Question: Does the plotted quantity increase or decrease?
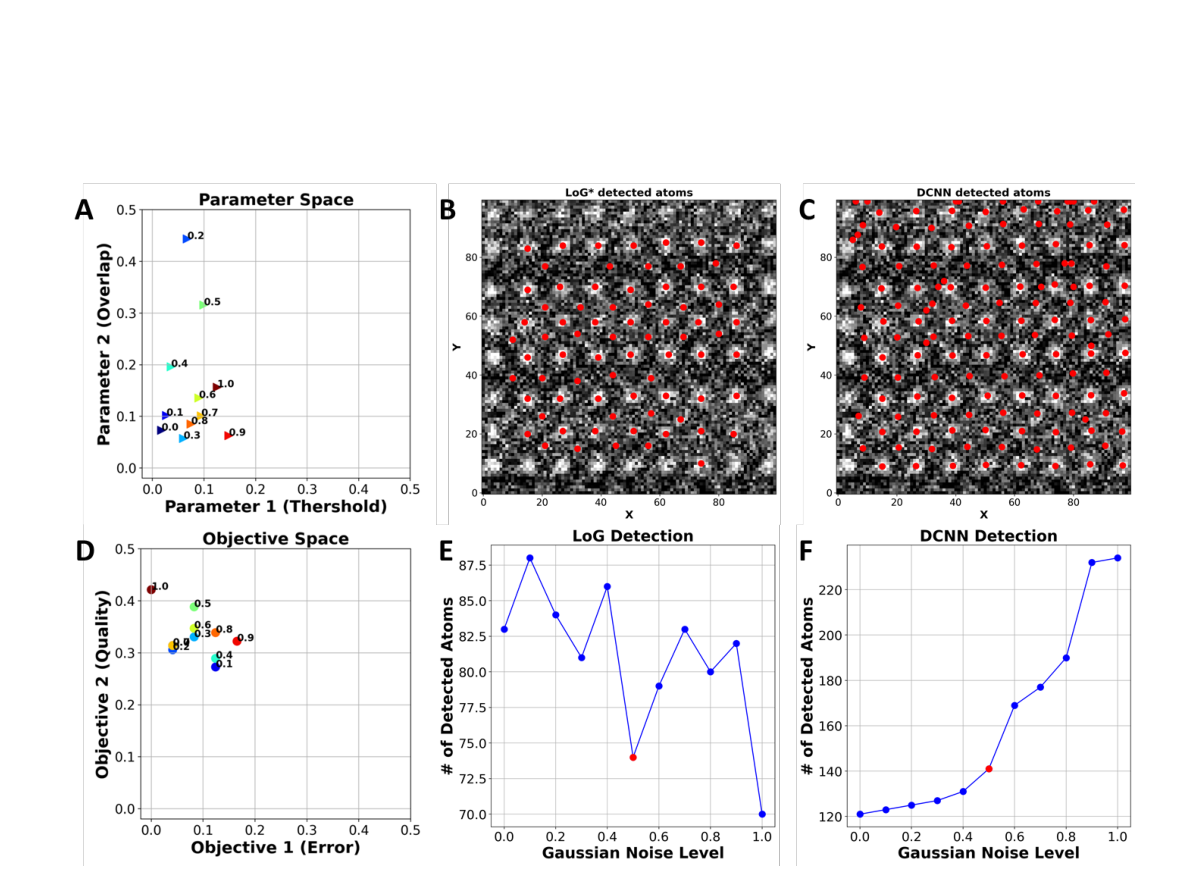
Answer: increasing